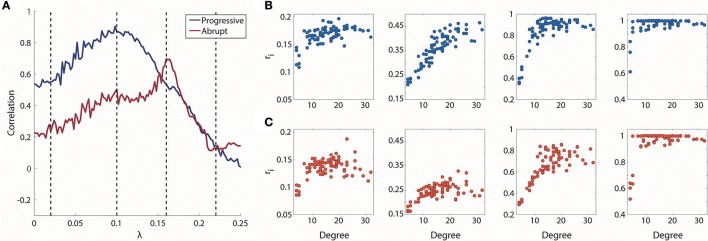
Relationship between degree and local order parameter ri for coupling strength λ. (A) Spearman correlation between degree and median local order parameter ri for coupling strength λ. Blue line indicates progressive transition and red line indicates abrupt transition. Black dotted vertical lines indicate λ = 0.02, 0.1, 0.16, and 0.22. Four representations of degree vs. ri for λ = 0.02, 0.1, 0.16, and 0.22 (from left to right) in (B) progressive and (C) abrupt transition (Spearman correlation = 0.55, 0.87, 0.53, and 0.14 for gradual; Spearman correlation = 0.24, 0.50, 0.70, and 0.12 for abrupt transition).